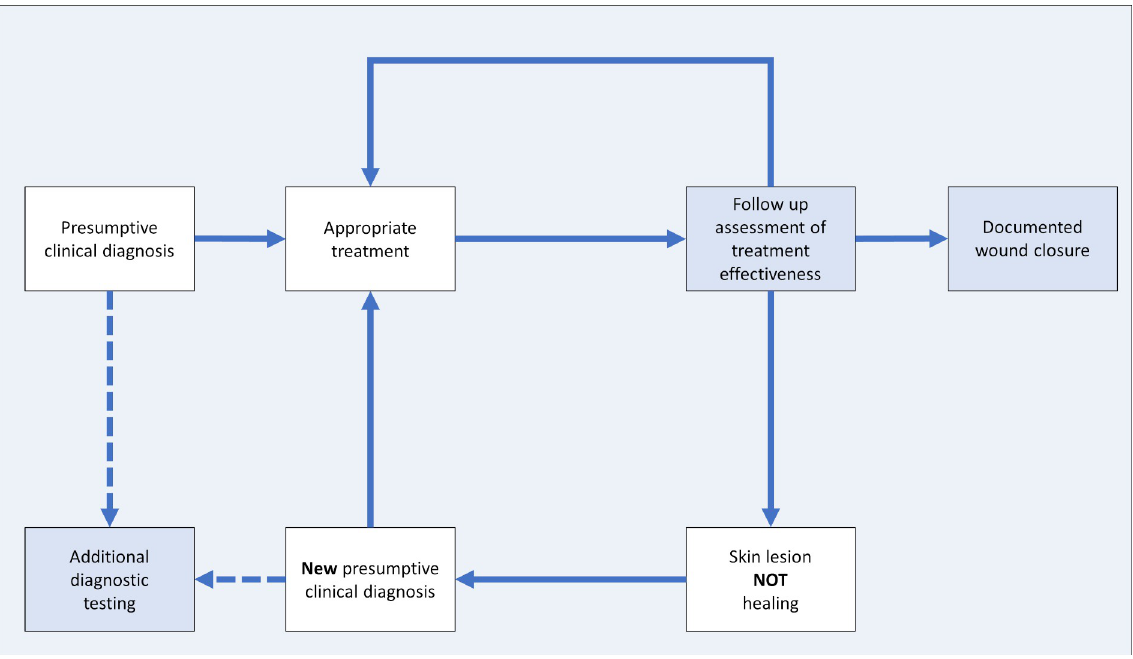
Fig 2. Diagnostic cycle to review presumptive diagnosis and treatment. Assessment steps leading to either confirmation of a presumptive clinical diagnosis or revision (light blue-coloured boxes). Clinical investigators reviewed selected cases on-site or via mobile phone consultations and performed a systematic review of each case based on clinical data and wound photographs. In case of treatment failure, the cause of treatment failure was analysed and it was decided if the current diagnosis could be maintained, but treatment had to be adapted / reinforced / intensified or the diagnosis and treatment had to be revised. If it deemed indicated additional laboratory investigations and imaging (underlying bone disease—osteomyelitis) were ordered; this was done routinely for the specific presumptive diagnoses BU, tuberculosis, yaws, and osteomyelitis conducted at local facilities, national and international laboratories as